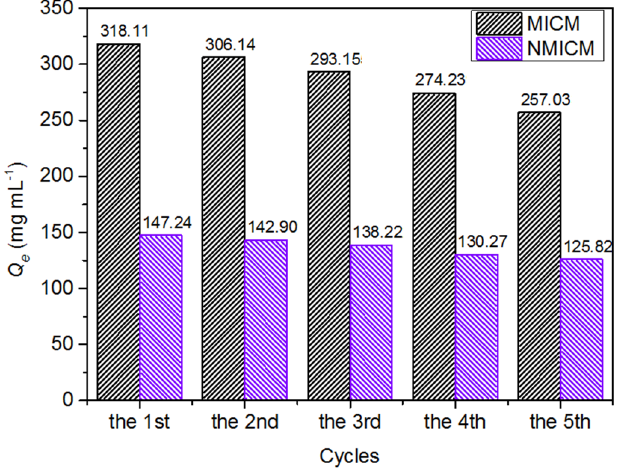
Figure 8. Reusability of MICM and NMICM.